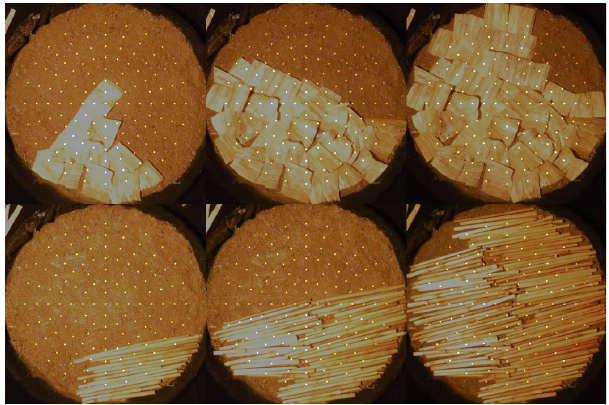
Figure 5. Digital photographs for determining crop residue cover (125 dot in 23-cm-radius tray).